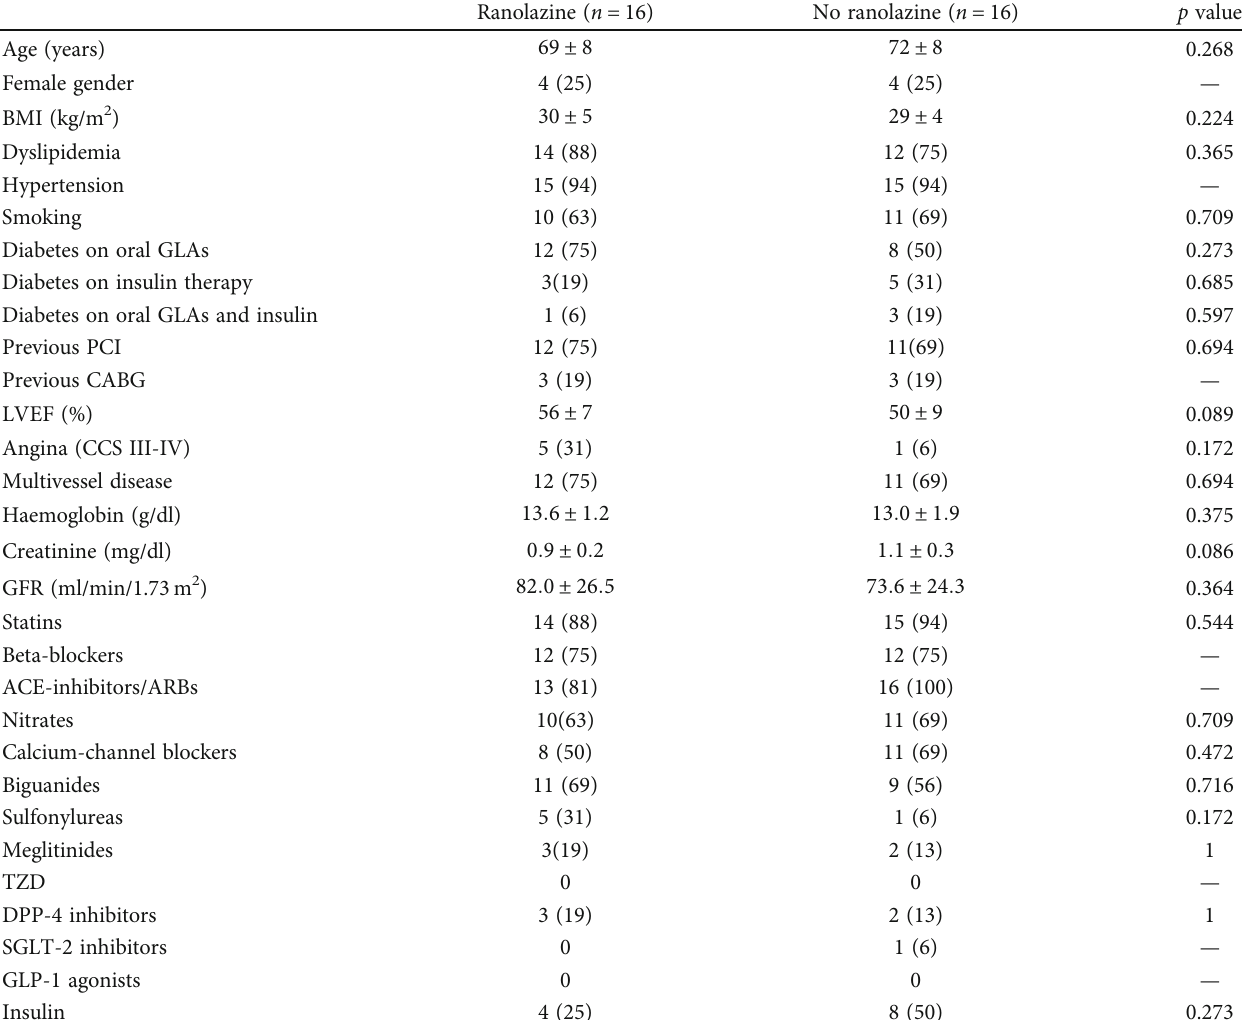
Table 1: Baseline characteristics of the two cohorts.